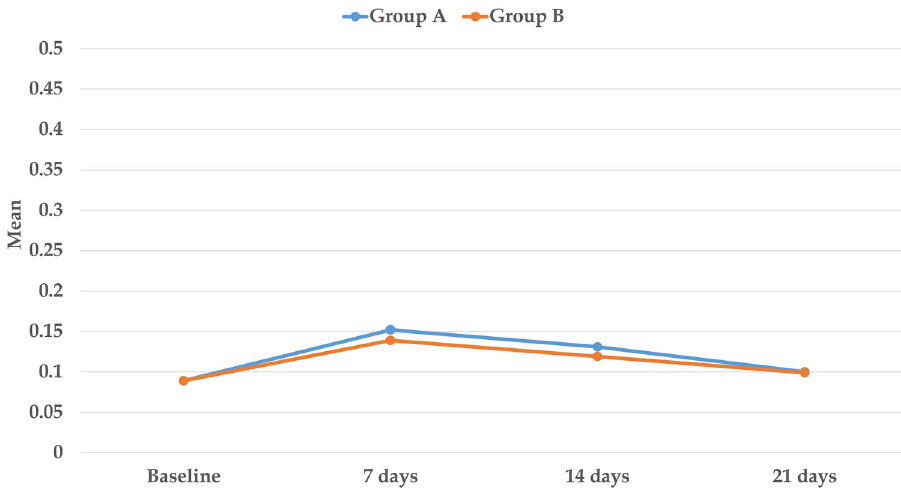
Figure 8. IL-1β levels (pg/ml/60 s) on the laser sides of the two study groups at different time